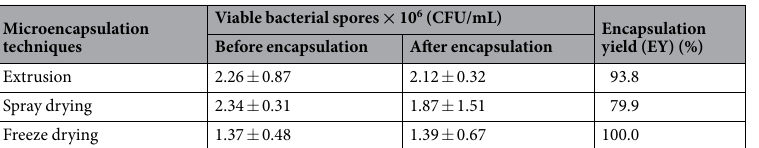
Table 1. Viable bacterial spore and encapsulation yield. Data are shown as the mean ± SE, derived from three replications. No means were significantly different (p > 0.05;